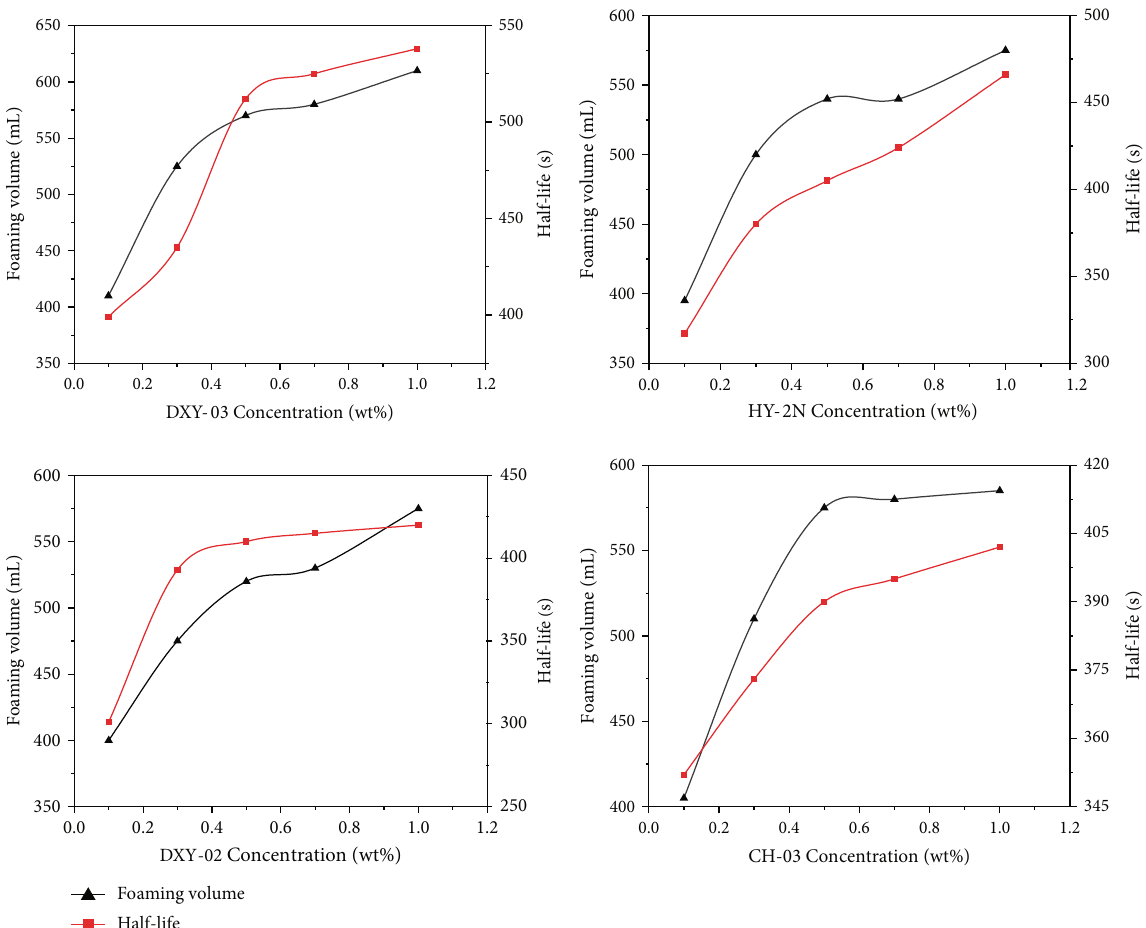
Figure 4: Foaming volume and half-life curves of four viscosity reducing and foaming